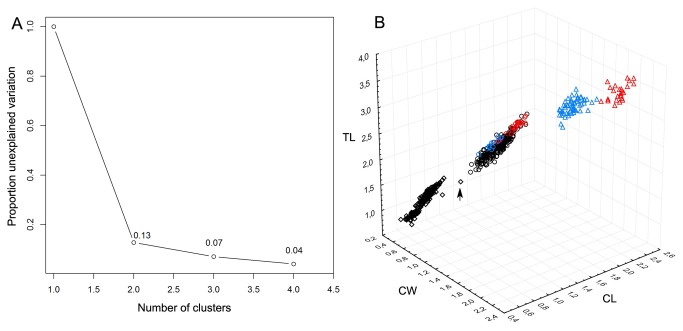
Cluster analysis and cluster number selection for chalimi.The proportion of unexplained variability in the dataset as a function of the number of chalimus clusters is shown in A. Total length (TL), cephalothorax length (CL) and cephalothorax width (CW) for experiment 2 (mm) are shown in B. Chalimus larvae assigned to chalimus cluster 1 are shown as diamonds. Chalimus larvae assigned to chalimus cluster 2 are shown as circles. Preadult 1samples are shown as triangles. Color codes: black=sex not determined, blue=male, red=female. Post-incubation measurements are not shown except for preadult I females (red triangles). The assignments to cluster (chalimus cluster 1 and 2) and morphological group (chalimus I/II, chalimus III/IV or preadult category) were congruent for all samples except the individual marked with an arrow.